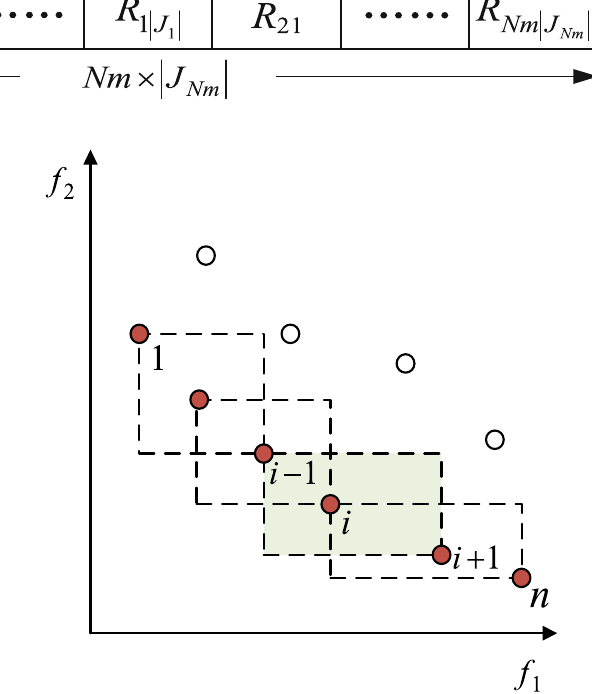
Fig. 4 Crowding distance calculation